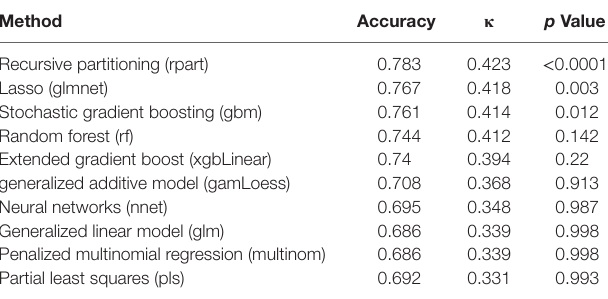
Table 3 | Model performance showing crude accuracy values (the ratio of right predictions over all predictions) and κ statistic (accuracy in relation to expected accuracy) for the evaluated machine learning classifiers in the test